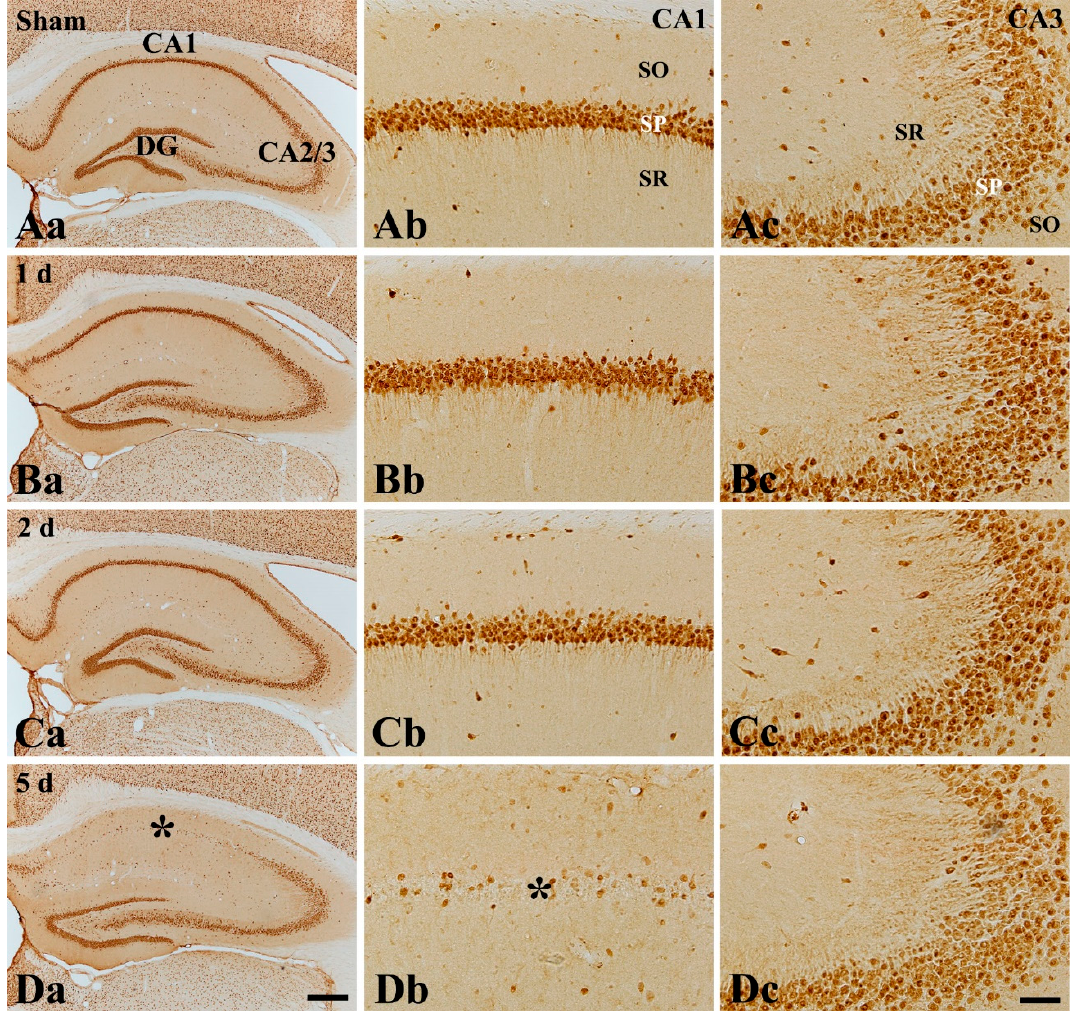
Figure 2. NeuN immunohistochemistry in the hippocampus proper ( Aa – Da ), CA1 ( Ab – Db ), and CA3 ( Ac – Dc ) field of the sham ( Aa – Ac ) and ischemia group at 1 day ( Ba – Bc ), 2 days ( Ca – Cc ), and 5 days ( Da – Dc ) after tFI. In the ischemia group, NeuN immunoreactive neurons are not altered at 1 and 2 days after tFI. However, NeuN-immunoreactive neurons are rarely detected in the stratum pyramidale (SP, asterisk) of the CA1 field, and not the CA2/3 fields, at 5 days after tFI. CA—cornu ammonis; SO—stratum oriens; SR—stratum radiatum. Scale bar = 400 µm ( Aa – Ca ) and 50 µm ( Ab – Db ) and ( Ac – Dc ).